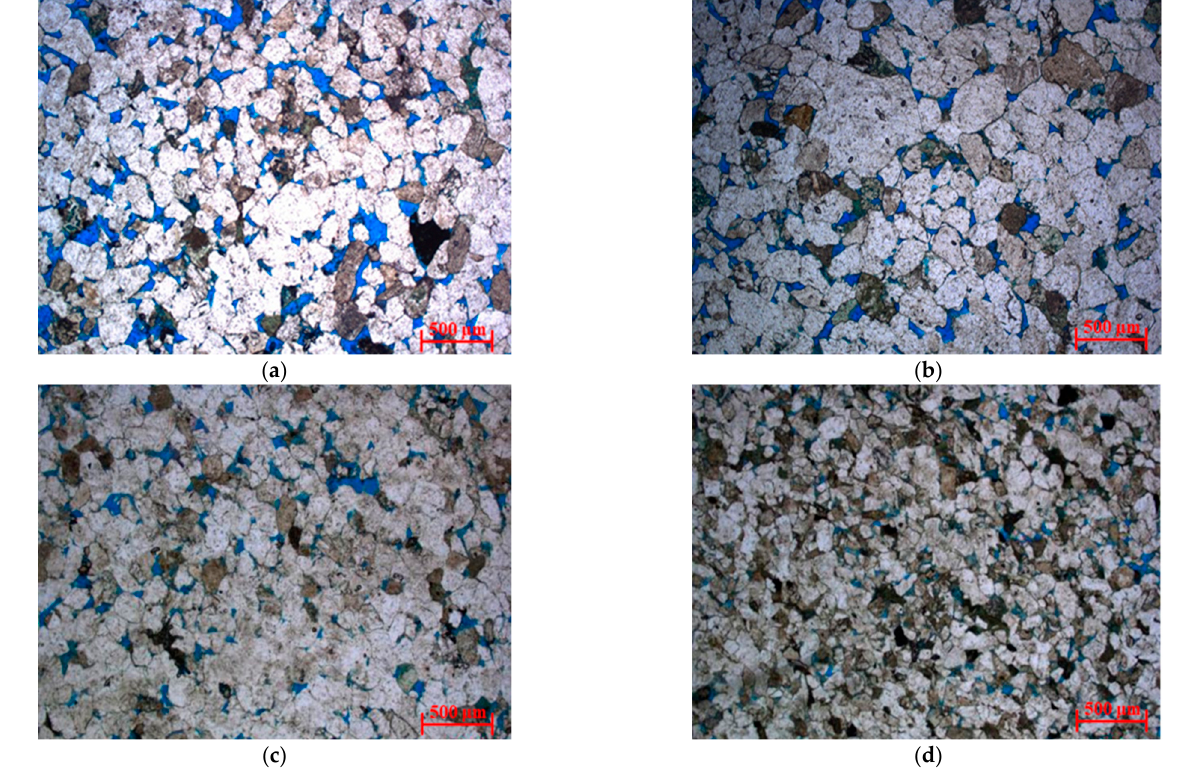
Figure 4. Casting sheet images of four types of rocks: ( a ) Type I ( Φ = 13.9%, K = 269 mD); ( b ) Type II ( Φ = 10.6%, K = 17.1 mD); ( c ) Type Ⅲ ( Φ = 10.4%, K = 4.9 mD); ( d ) Type Ⅳ ( Φ = 9.7%, K = 0.45 mD).